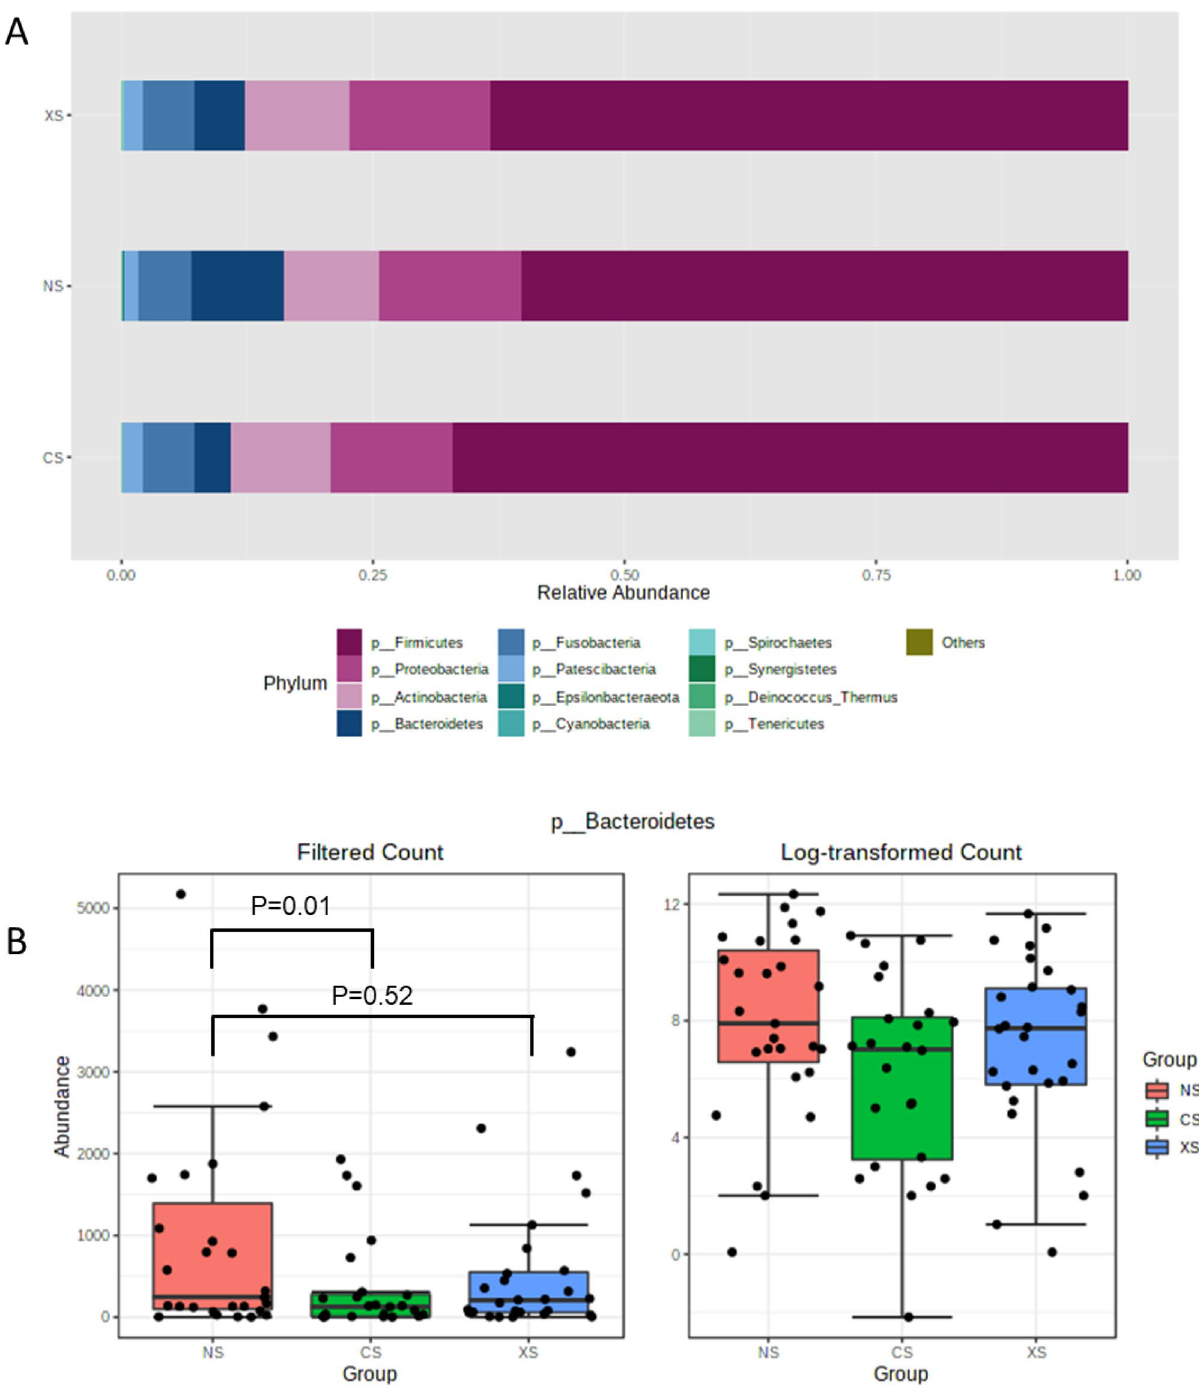
Figure 1. ( A ) Relative abundance of different phyla in the duodenal luminal microbiome of never-smokers (NS), current smokers (CS), and ex-smokers (XS). ( B ) Log-transformed abundance of phylum Bacteroidetes in the duodenal luminal microbiome of NS (red), CS (green), and XS Lactobacillus that had higher relative abundance in the CS group when compared to NS group (of a total of 11) were L. panis (FC = 6.4, FDR-adj. P = 2.65E-7), L. oris (FC = 6.88, FDR-adj. P = 4.62E-7) and L. murinus (FC = 7.28, FDR-adj. P = 2.38E-6). In addition, the relative abundance of genus Lactobacillus tended to be higher in the CS group when compared to the XS group, but this did not reach statistical significance (FC = 2.17, P = 0.06, FDR-adj. P = 0.28, Fig. 5A, Supplemental Table 1). There was no significant difference in the relative abundance of genus Lactobacillus in the XS group when compared to the NS group (Fig. 5B, P = 0.1, FDR-adj. P = 0.36).